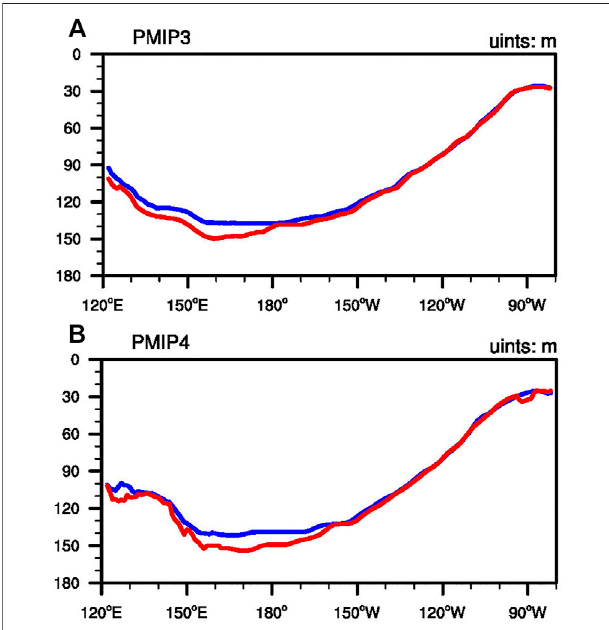
FIGURE 3| Plots for MME of mean thermocline depth alone the equator (averaged between 5 o S and 5 o N) derived from (A) PMIP3 and (B) PMIP4 models. The depth of the mean thermocline is calculated from the location at the maximum vertical gradient of the mean temperature. Blue and red lines indicate PI and MH simulations,